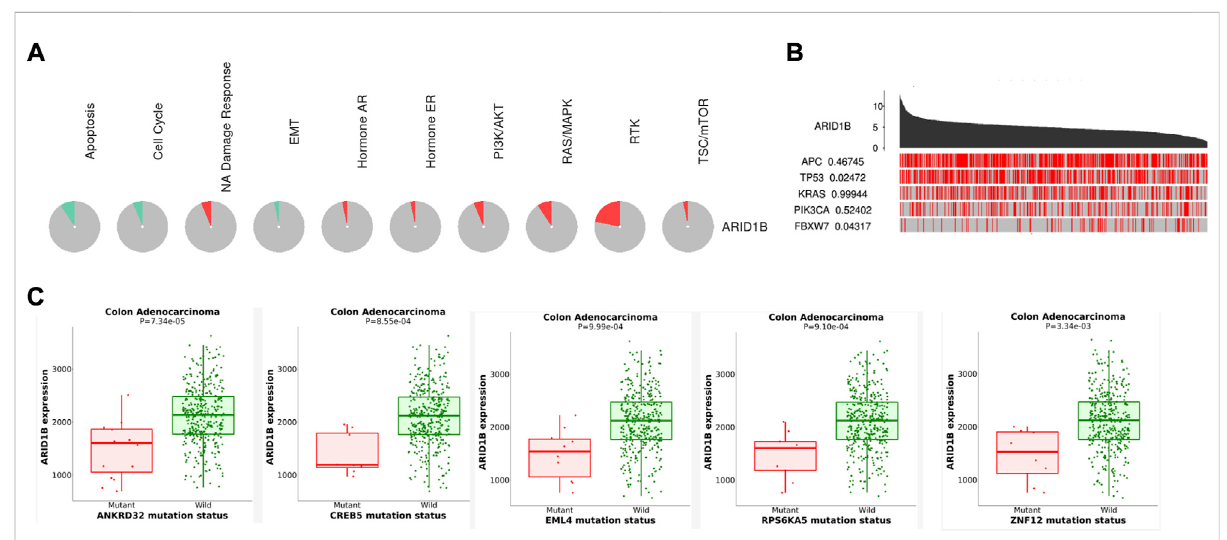
FIGURE 5 Enrichment pathways of ARID1B. (A) ARID1B is inhibited and activated in pathways indicated with green and red colors, respectively (B) A permutation test p -value of ARID1B between driver mutated and non-mutated samples (C) Analysis correlation between ARID1B expression and some mutated genes that cause a low level of ARID1B was